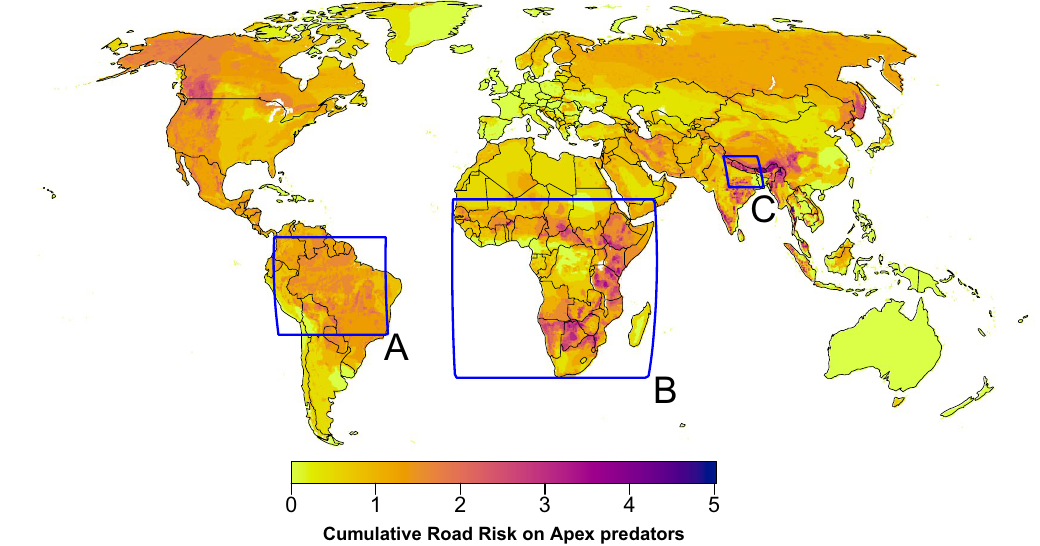
Figure 3. Cumulative road risk of apex predators globally used for predicting the potential impact of future roads. The cumulative risk is based on the aggregation of the road risk for each species and the presence of protected areas (see Methods), calculated at 5-arcmin resolution. Blue boxes indicate the three case studies used for assessing the potential impact of future road developments in ( A ) the Brazilian Amazon, ( B ) Africa, and ( C ) Nepal. Maps were generated in R software v4.0.3 (https:// www.R- proje ct.